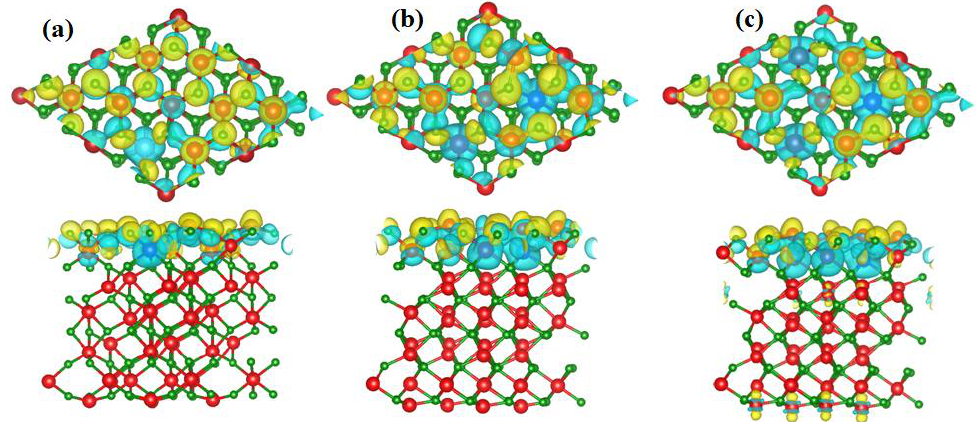
Figure 2. Charge density difference plots top and side views of ( a ) mono-doped X element ( b ) bimetallic-doped (Zn, X ), and ( c ) bimetallic-doped (Zn, 2 X ) of {0001} surface; yellow and cyan colours show accumulation and depletion of charge density, respectively.